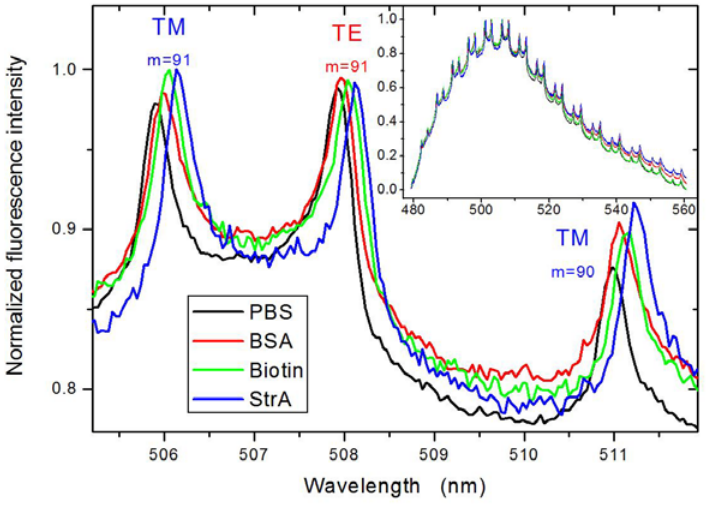
Figure 3. WGM spectra obtained from a single surface-adsorbed fluorescent polystyrene bead with a nominal diameter of 10 µ m in dependence of the same sequence of biomolecules adsorbed onto the particle surface as used in the SPR study; the inset shows the overview over the entire emission wavelength range of the fluorescent dye applied, while the main figure displays a close-up of the most intense modes. The latter are labeled according to their respective polarization (TM/TE) and mode number m . It should be noted that under the given conditions, only 1st order modes are observable.